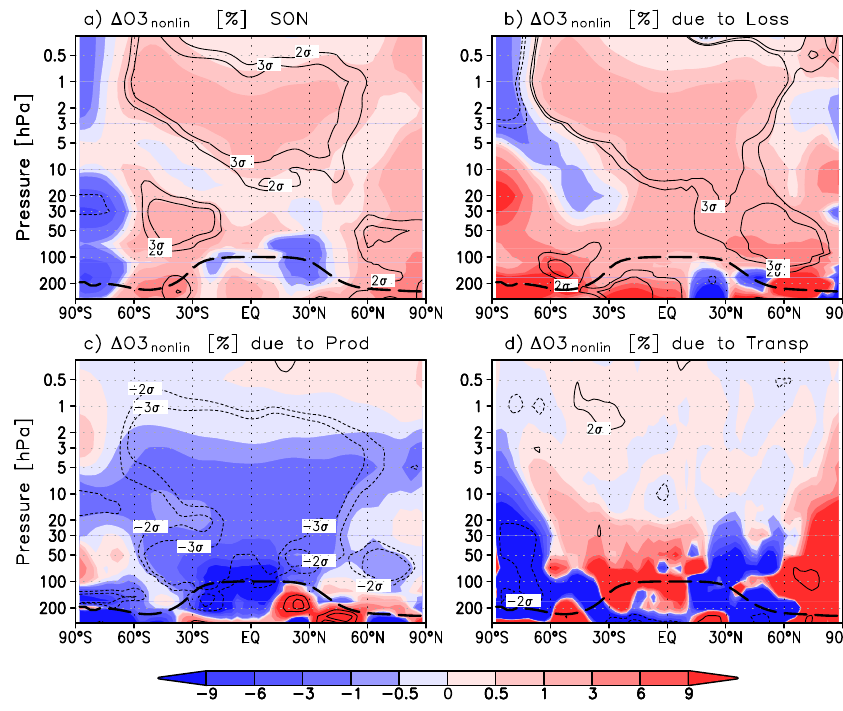
Figure 6. Same as Fig. 2 but for the SON (September–October–November) mean. See text for details.